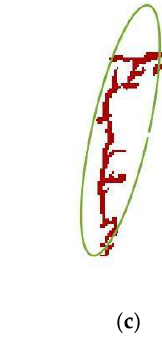
Figure 6. Misidentification of connected components (CCs) using existing edge detection methods. ( a ) Joining horizontal and vertical architectural lines and ( b , c ) joining architectural lines and cracks.